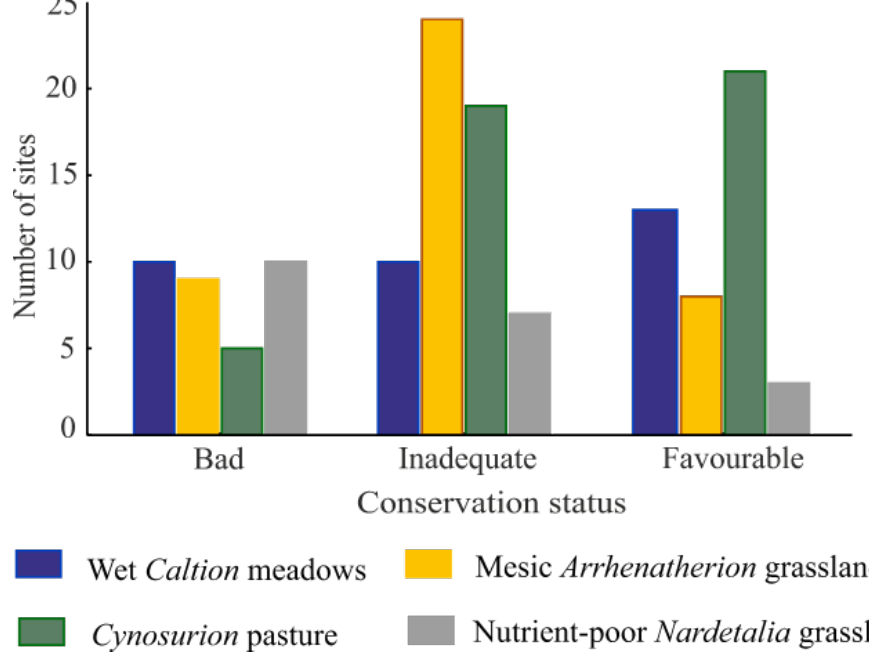
Figure 6. Conservation status of four grassland types evaluated on the basis of an assessment of their structure and function.